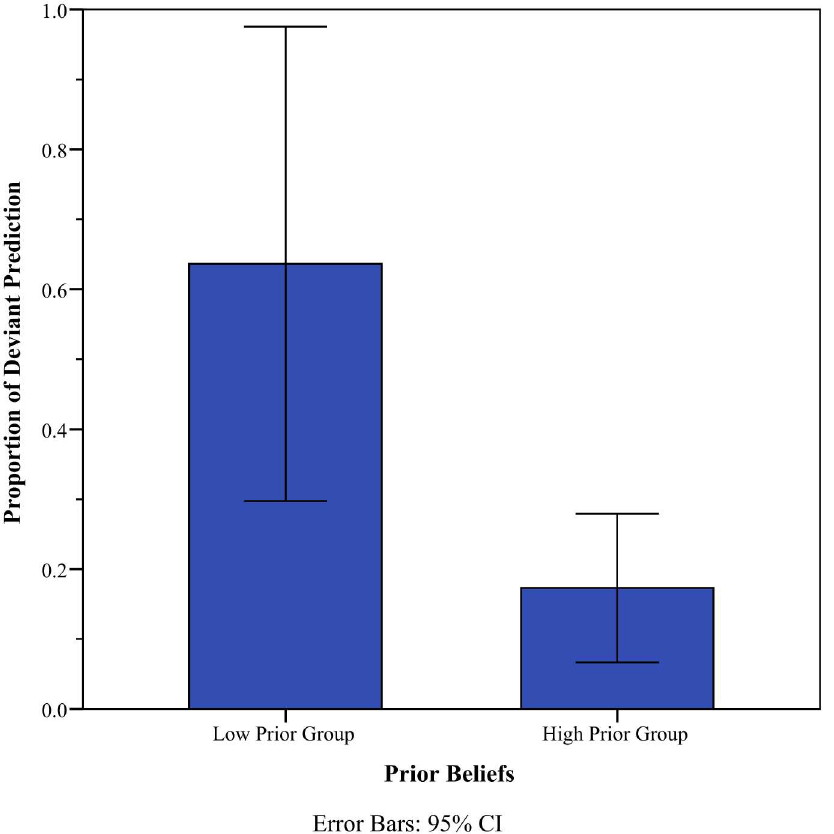
Fig 4. Deviation from initial opinions in the prediction of the first game. The response variable is the proportionof the participantswhose prediction for the first game was oppositetheir prior beliefs. N = 63.